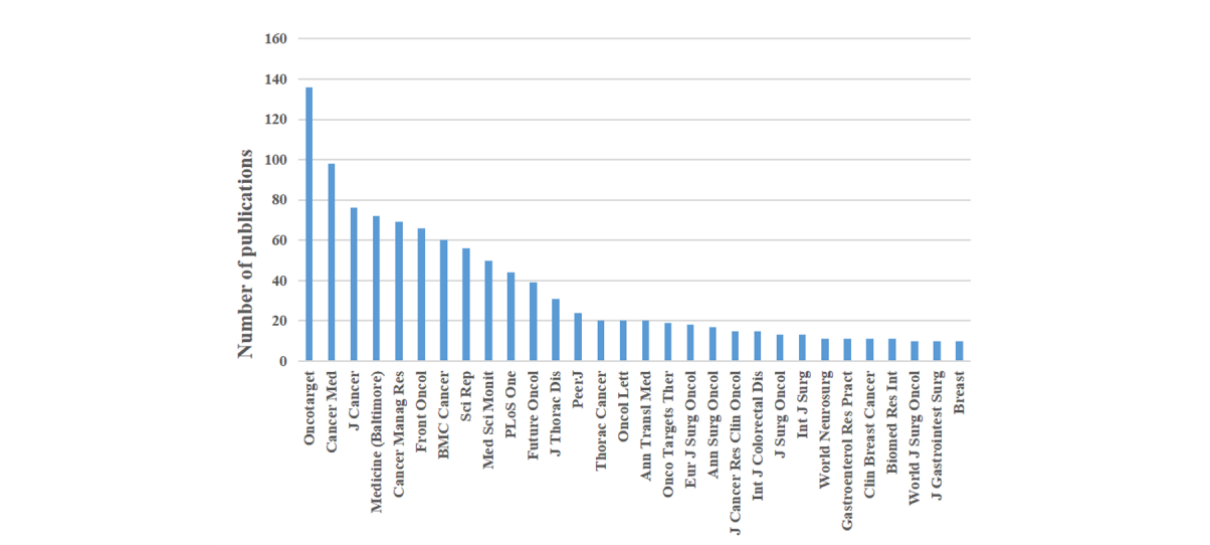
Figure 5. The distribution of the publications stratified by the top 30 most common